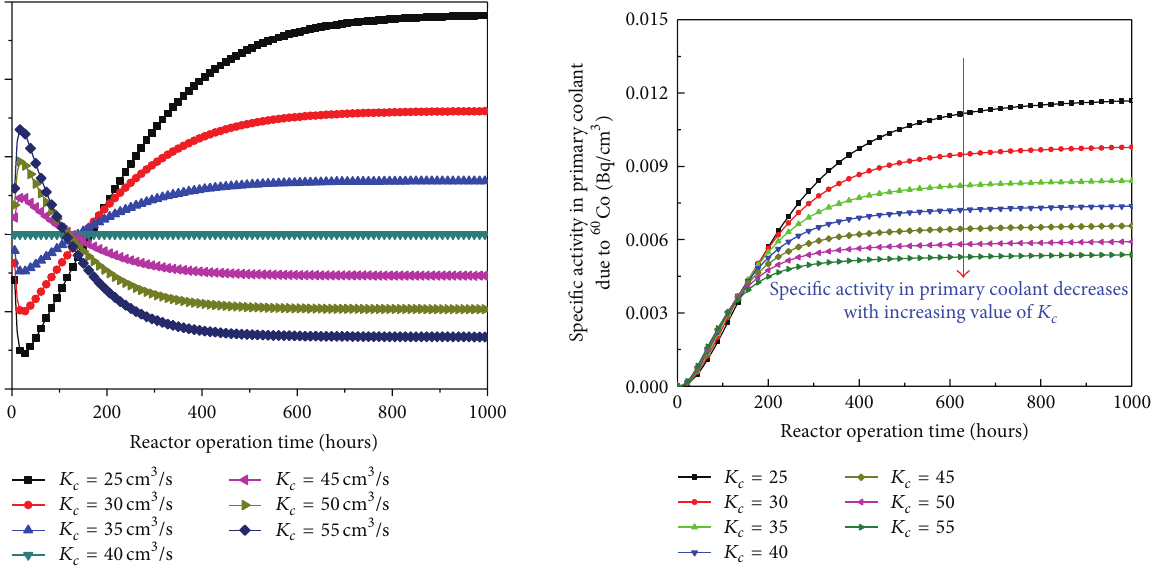
Figure 6: Normalized specific activity of 58 Co as a function of 𝐾 𝑐 . the specific activity has the value 432 Bq-cm −3 after 1,000 h of reactor operation. This value decreases to 199 Bq-cm −3 at = 55 cm 3 -s −1 as shown in Figure 7 and Table 4. 𝐾 𝑐